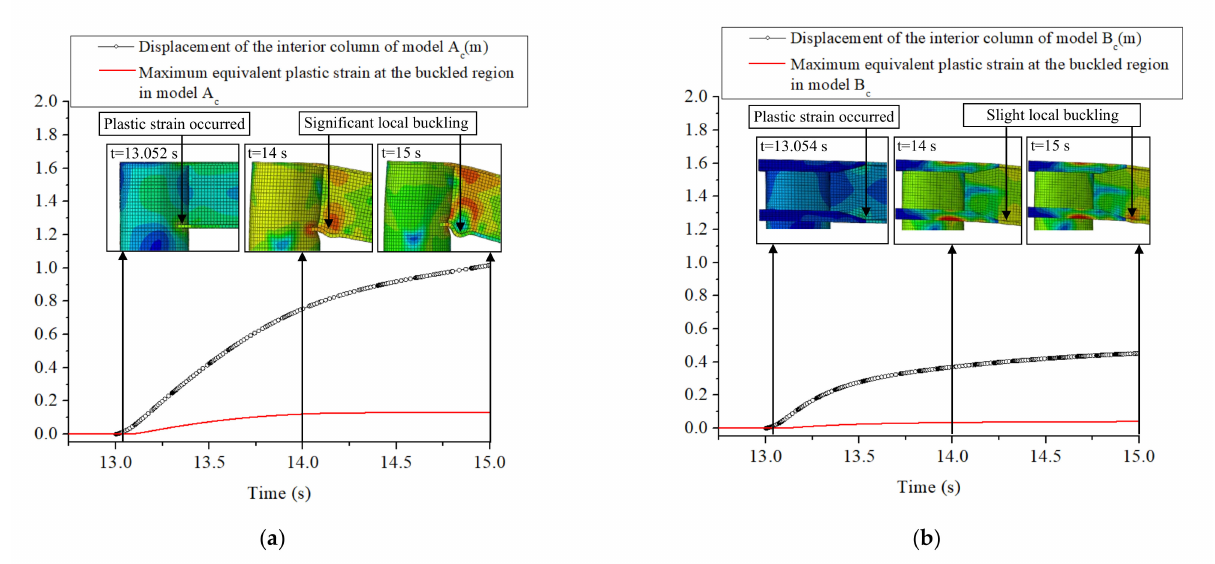
Figure 10. Time history curves of the displacements of the interior columns and the maximum equivalent plastic strains at the buckled regions under load (iv): ( a ) Model A c ; ( b ) Model B c .